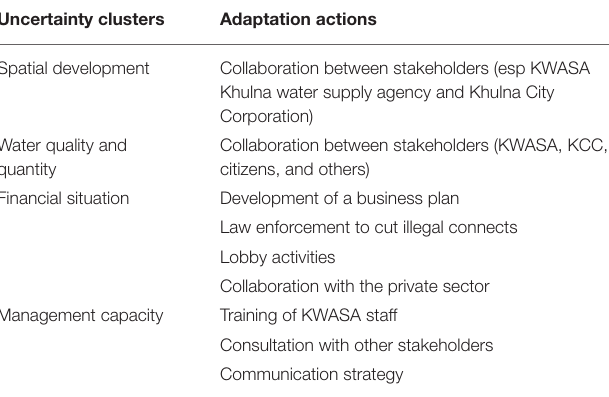
TABLE 2 | Adaptation actions identified in the adaptive planning expert workshop.